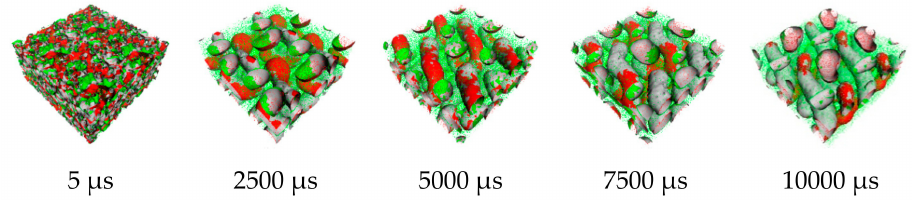
Figure 5. Snapshots of morphology evolution at annealing temperature of 393 K. Red and green regions represent PS and PI, respectively.